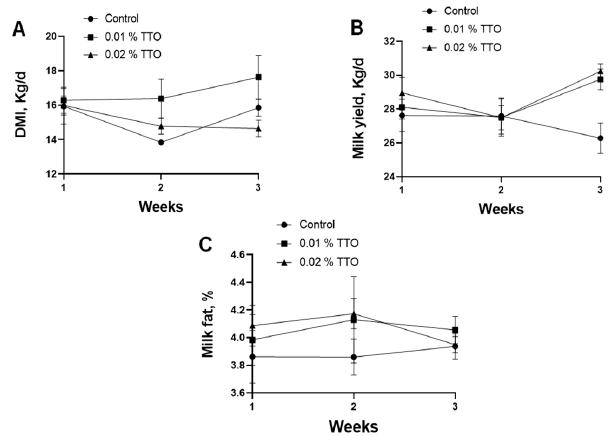
Figure 1. Effects of TTO on DMI, milk yield, and milk fat in different postpartum periods. ( A ) Effects of TTO on DMI in different postpartum periods. ( B ) Effects of TTO on milk yield in different postpartum periods. ( C ) Effects of TTO on milk fat in different postpartum periods.